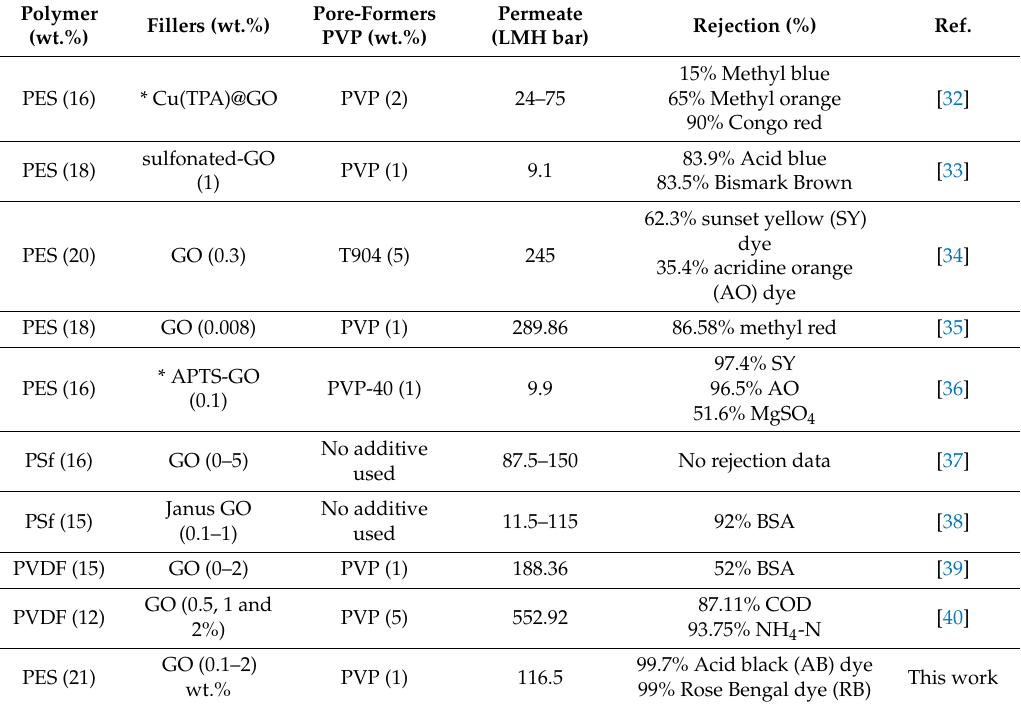
Figure 14. Dependence of zeta potential of dye solutions on pH value. Table3. DemonstratesthecomparisonofthisworkwiththerecentpublishedGOmixedmatrixmembranes. Polymer